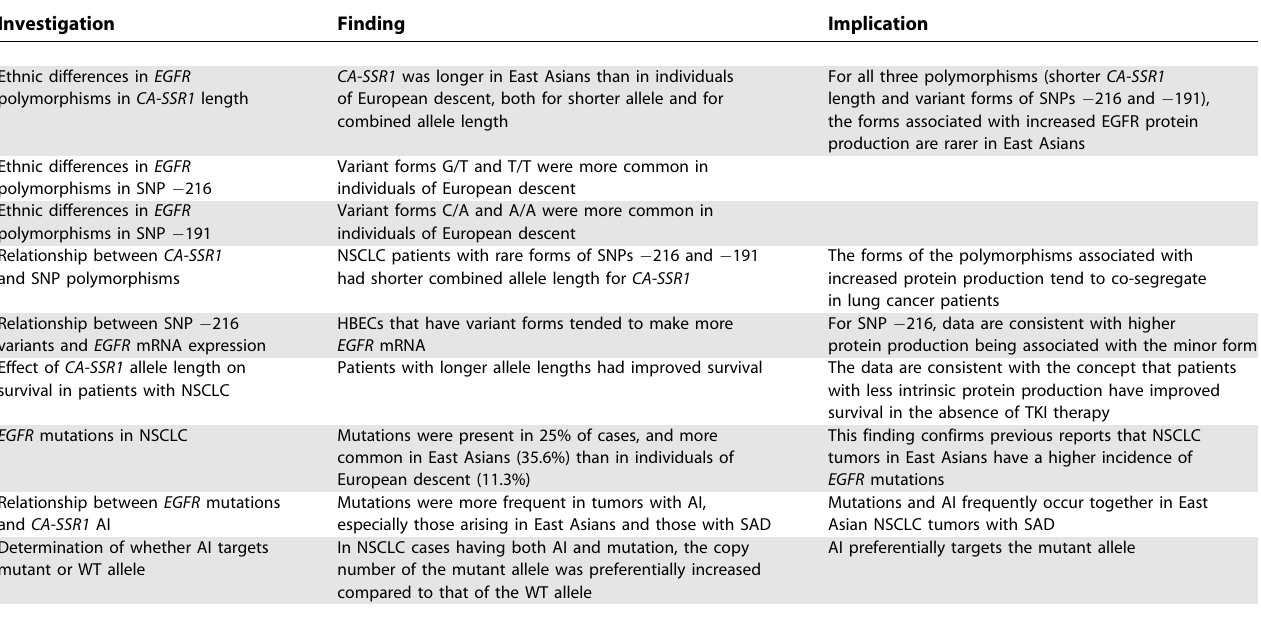
Table 1. Summary of Investigations Performed, Results, and Their